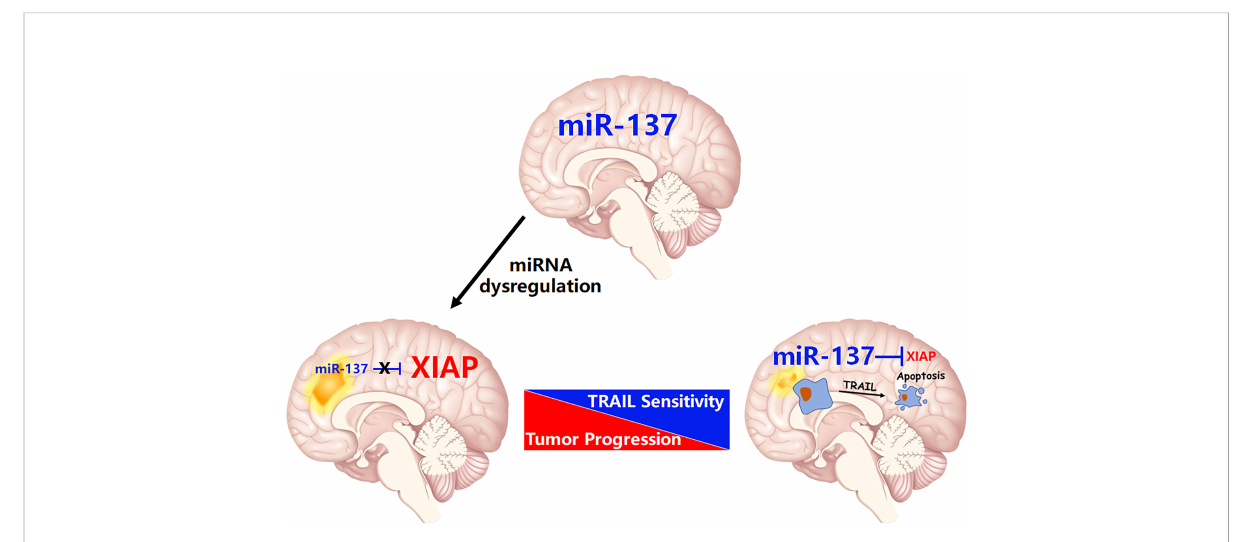
FIGURE 8 The schematic diagram of this study: miR-137 suppresses XIAP expression to sensitize TRAIL-induced cell death in GBM.